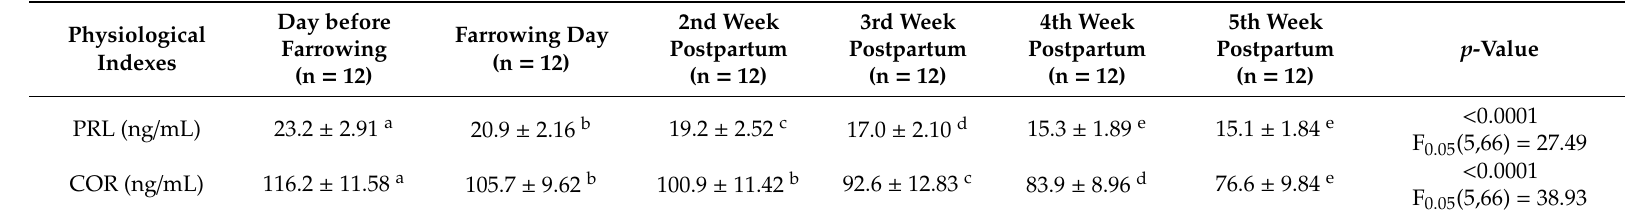
Table 7. Physiological statuses and immune levels of sows at di ff erent